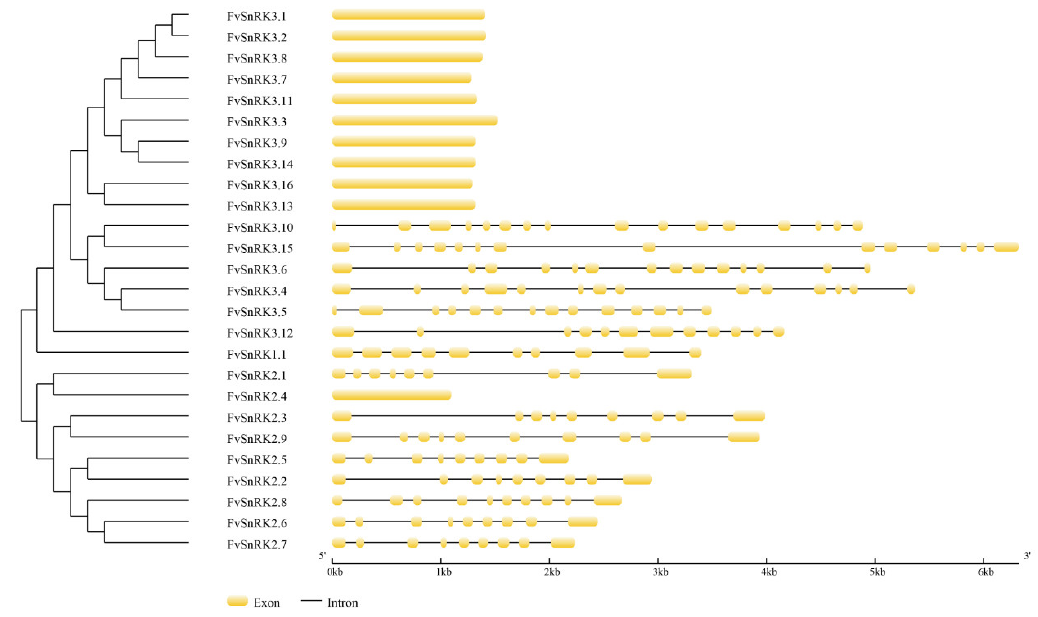
Figure 1. Gene structure analysis of FvSnRKs . Exon–intron structure was analyzed in the Gene Structure Display Server (GSDS) program. The yellow boxes indicate exons, and the gray horizontal lines indicate introns. The scale bar represents 6 kb.